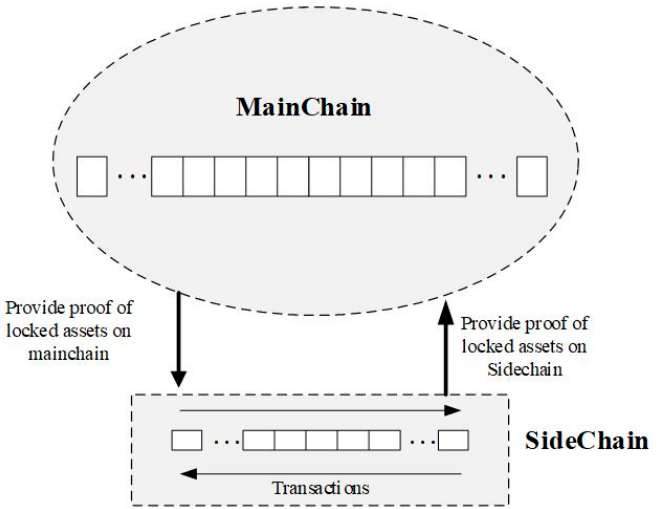
Figure 7 . Sidechain data processing concept. Figure 7. Sidechain data processing